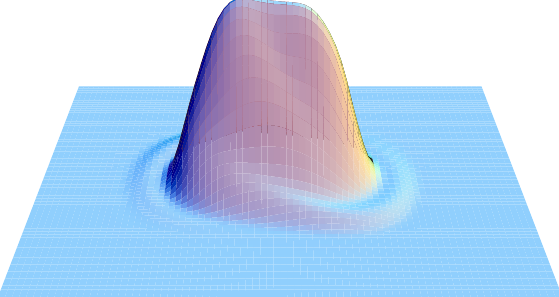
FIG. 17. (Color) Simulated phase-space distribution of a 150 mA fully stretched unstable bunch after the oscillations have steadied. The ring impedance consists of main-cavity and harmonic-cavity fundamental rf modes. Their tunes are realistically adjusted for beam-loading compensation. There is no relaxation cycle. Machine parameters are given in Table